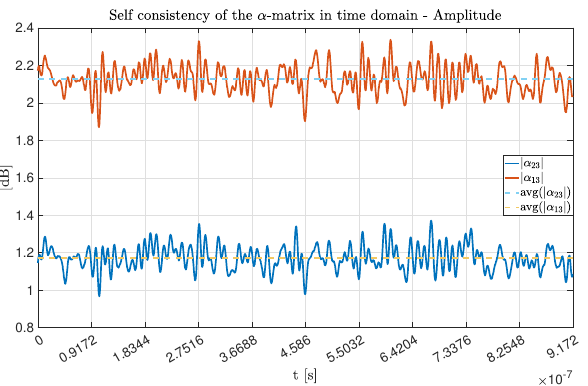
Figure 5. Amplitude values for the α -matrix coefficient during an experimental snapshot.